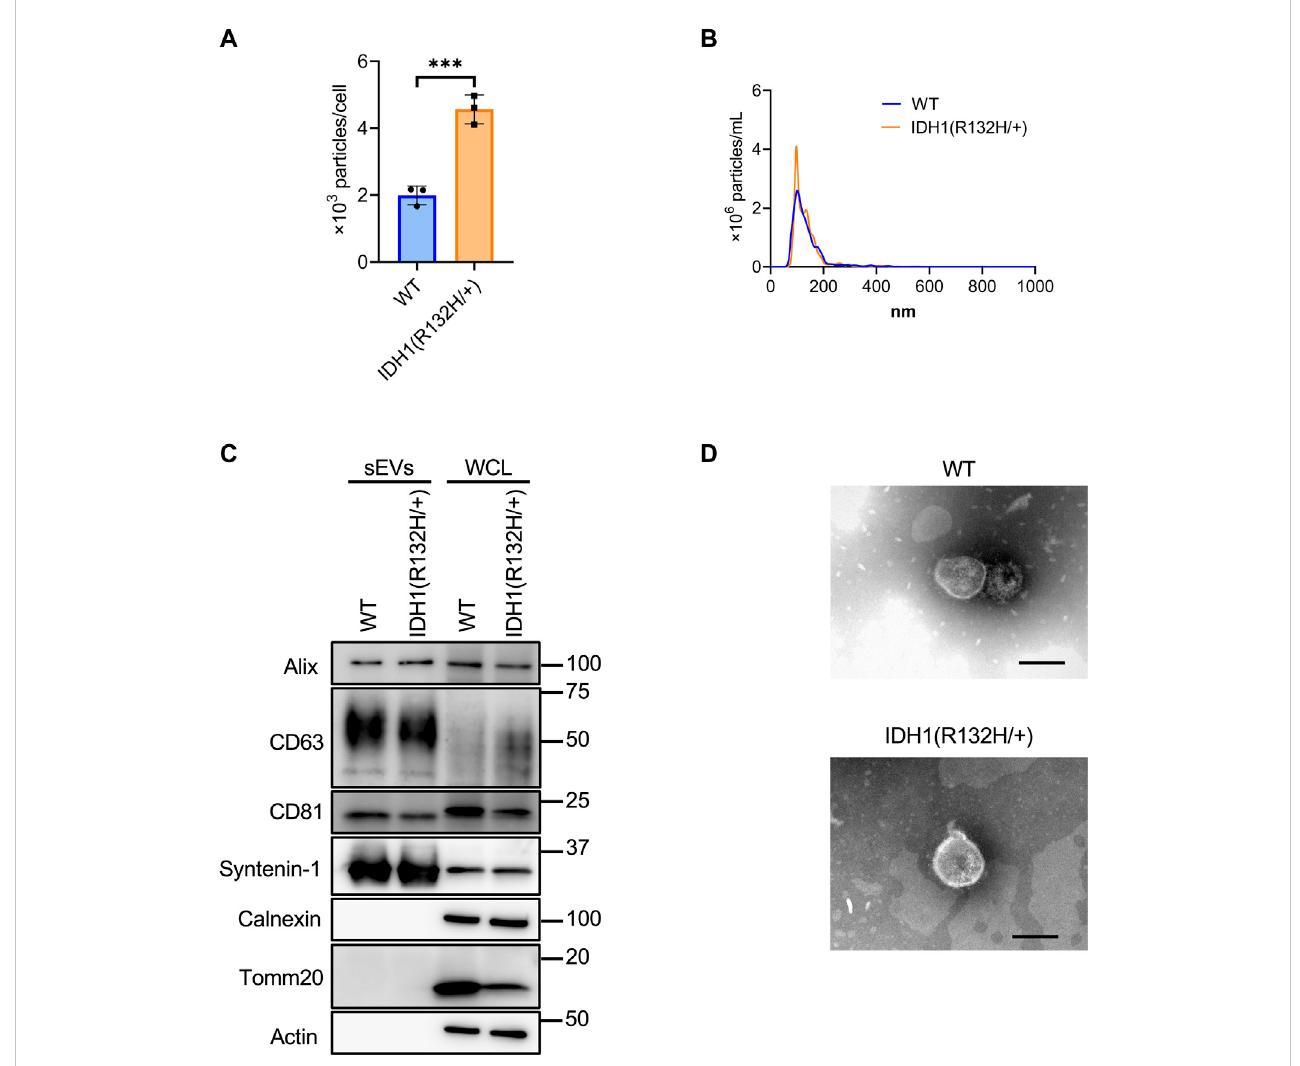
FIGURE 4 Characterization of sEVs derived from HCT116 wild-type and HCT116 IDH1(R132H/+) cell lines. (A) The number of particles from sEVs derived from HCT116wild-type(WT)andIDH1(R132H/+)celllines.*** p -value < .001byStudent ’ st-test. (B) ParticlesdistributionofsEVsfromHCT116WTandIDH1(R132H/ +)cells. (C) WesternblottinganalysisofAlix,CD63,CD81,syntenin-1,calnexin,tomm20,andactin,whichwasusedasaloadingcontrol.Theinjectionamount was 1.0 μ g for the sEV sample and 10 μ g for the WCL sample. (D) Transmission electron microscopic images of sEVs derived from HCT116 WT and IDH1(R132H/+) cells. Scale bar, 100